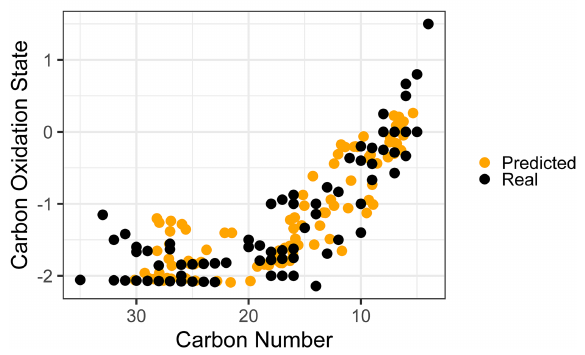
Figure 5. True versus predicted chemical properties distribution of ambient sample organic species within a carbon number vs. carbon oxidation state